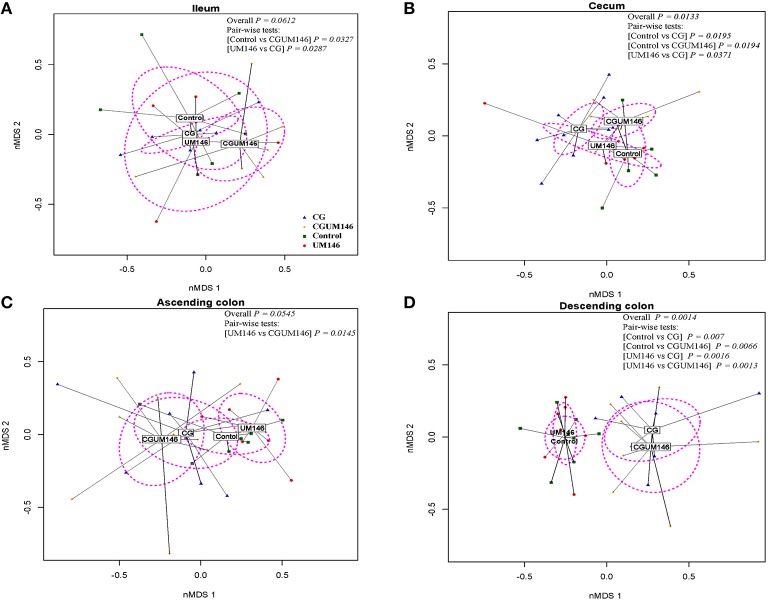
Non-metric multidimensional scaling (nMDS) ordination plot, a measure of relative difference in the bacterial community composition in the: (A) ileum; (B) cecum; (C) ascending colon; and (D) descending colon of pigs treated with carrageenan gum (CG) and inoculated with adherent invasive Escherichia coli (AIEC) strain UM146. The colored points are shaded according to different treatment groups. CG: pigs received 1% carrageenan gum only in drinking water daily; UM146: pigs were inoculated with AIEC UM146 on day 8 of the study; CGUM146: pigs received CG from day 1 of the study and were inoculated with AIEC UM146 on day 8 of the study. Pigs in designated groups received 100 mL of AIEC UM146 culture (108 CFU/mL) in feed. The P-values were calculated using PERMANOVA. For the pair-wise tests, only the significant P-values are included.